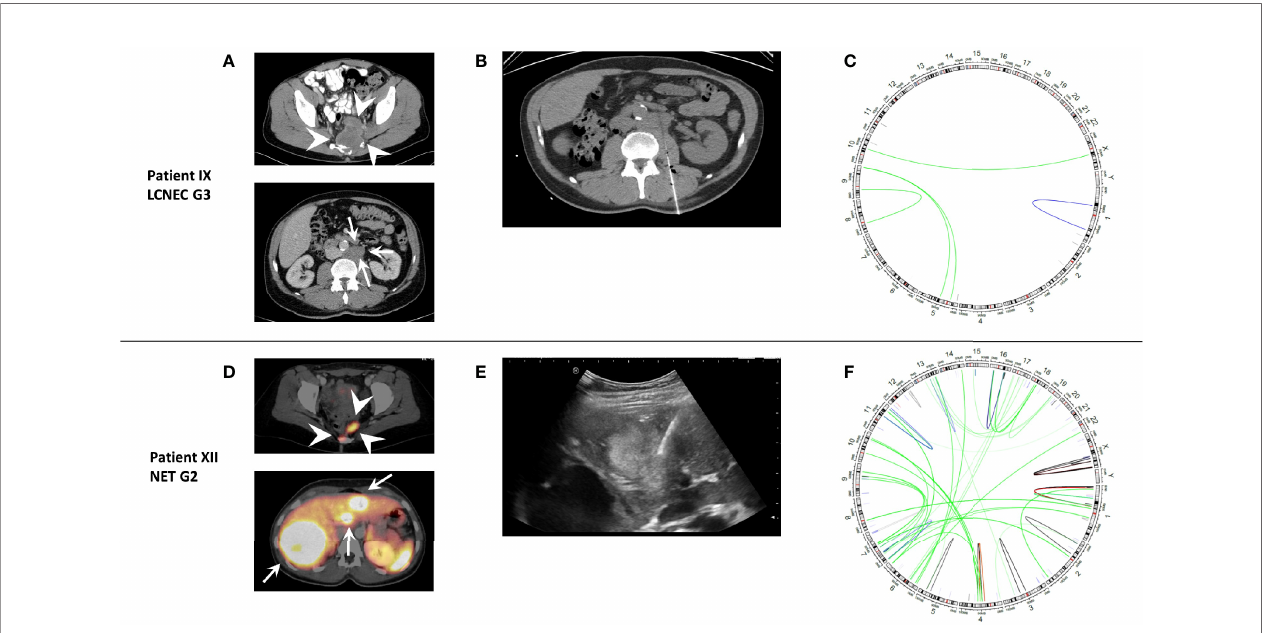
FIGURE 3 | Representative imaging and genomic rearrangements of molecularly characterized patients IX (LCNEC G3) and XII (NET G2). (A) CT and (D) DOTATOC- PET/CT of presacral primary (white arrowheads) and metastases (white arrows). (B) CT-guided biopsy of retroperitoneal lymph node metastasis and (E) ultrasound- guided biopsy of liver metastasis for fresh tissue for genomic analysis. (C, F) Circle plots of genomic rearrangements. Despite slightly lower tumor mutational burden, case XII shows a much higher number of rearrangements as a sign of homologous DNA repair de fi ciency possibly due to a pathogenic frameshift SETD2